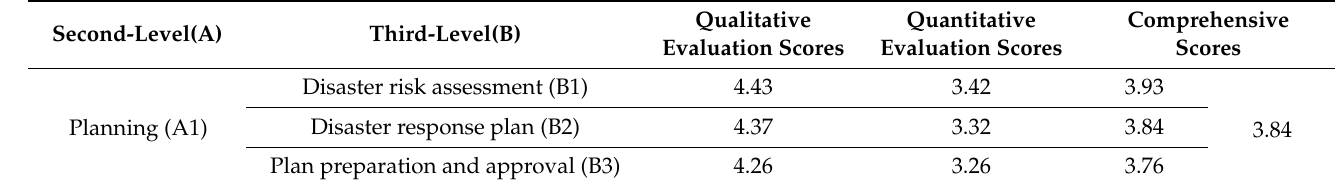
Table 4. Comprehensive scores of second- and third-level